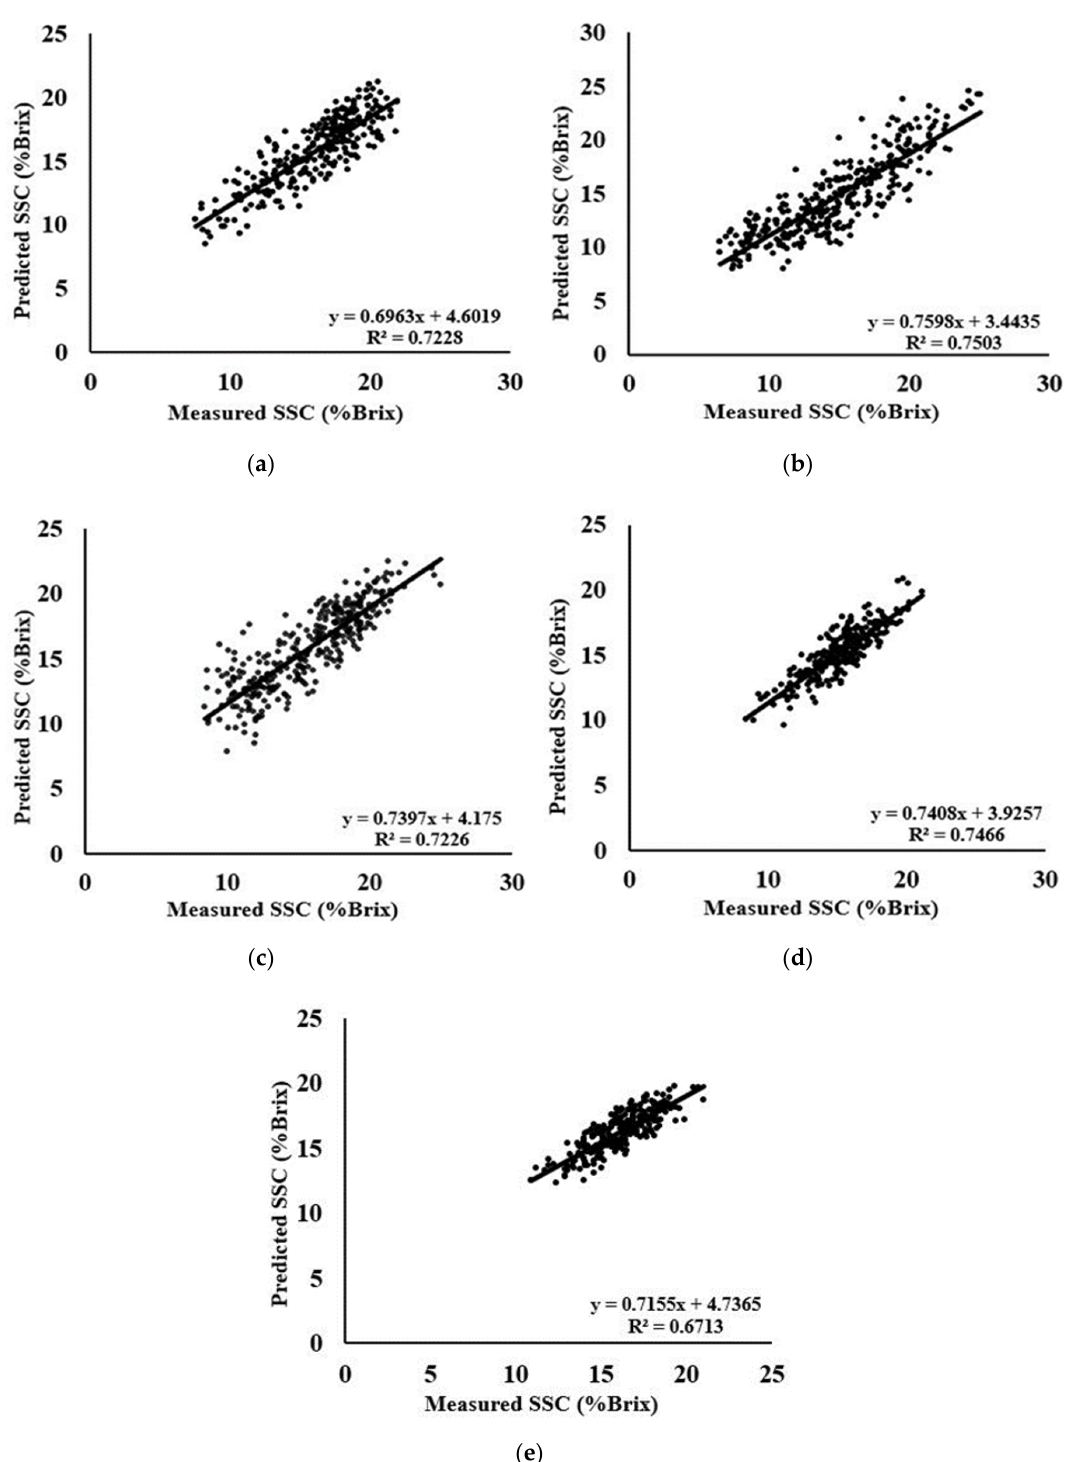
Figure 5. Scatter plots of measured versus predicted SSC using ( a ) second derivative; ( b ) MSC + SNV; ( c ) SNV; ( d ) MSC + OSC; and ( e ) MSC + SNV for G, M, S, W, and Y area, respectively.